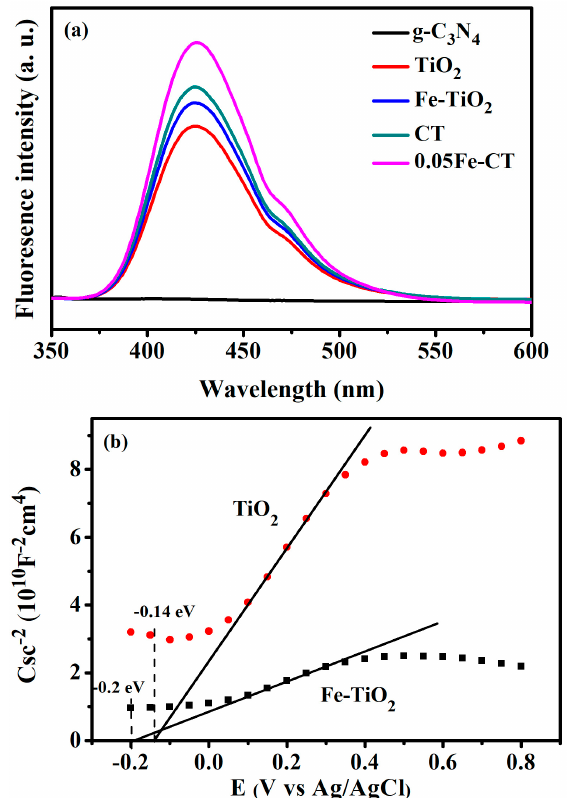
Figure 9. ( a ) Photoluminescence (PL) spectra of g ‐ C 3 N 4 , CT, Fe ‐ TiO 2 , and 0.05Fe ‐ CT in a 1 × 10 − 3 mol dm − 3 basic solution of terephthalic acid under visible light irradiation after 80 min; ( b ) The Mott– Schottky plots of TiO 2 and Fe ‐ TiO 2 for determining the flat ‐ band potentials of